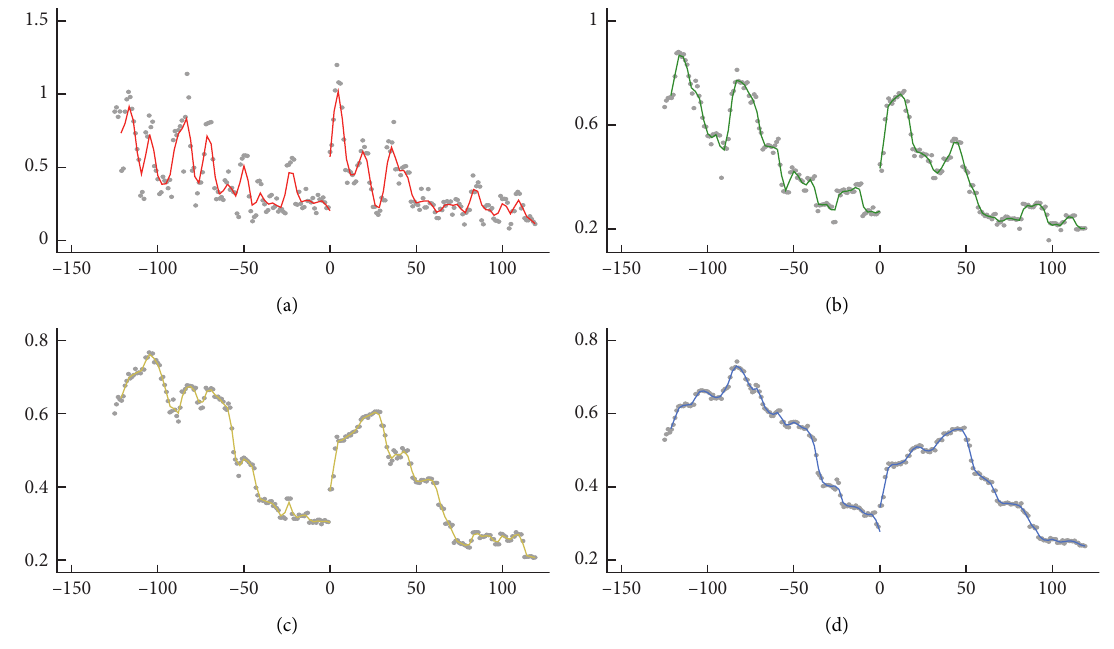
Figure 1: The RDD results of the material industry. (a) hv5, (b) hv15, (c) hv30, and (d)